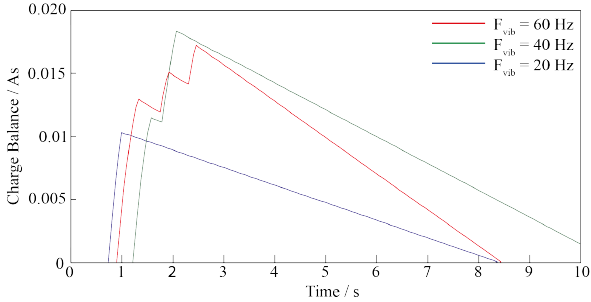
Figure 16. Measured charge balance of the start-up phase.